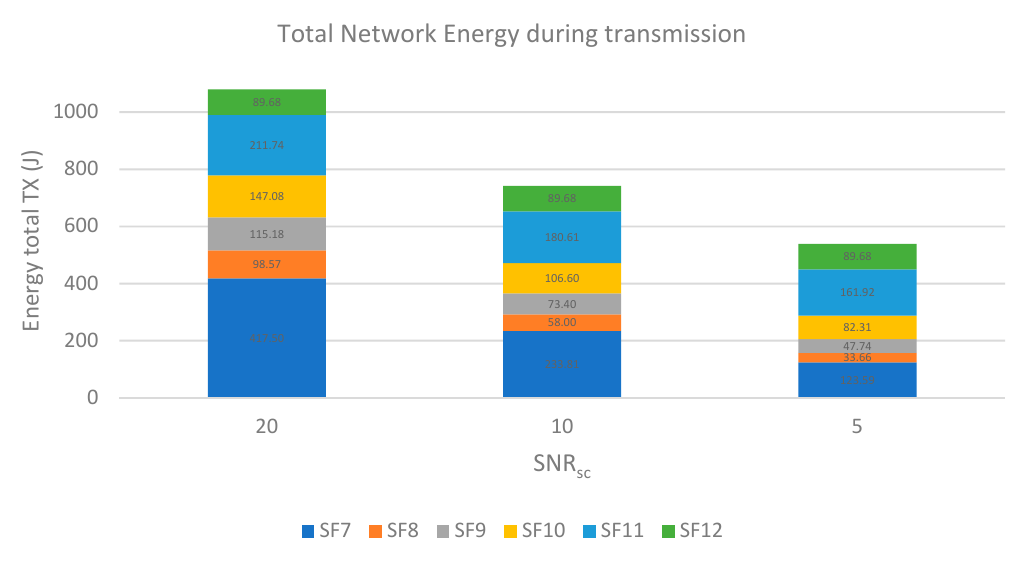
Figure 13. Total energy consumed by transmissions by EDs in the network for 24 h with upload periodicity of 1800 s.